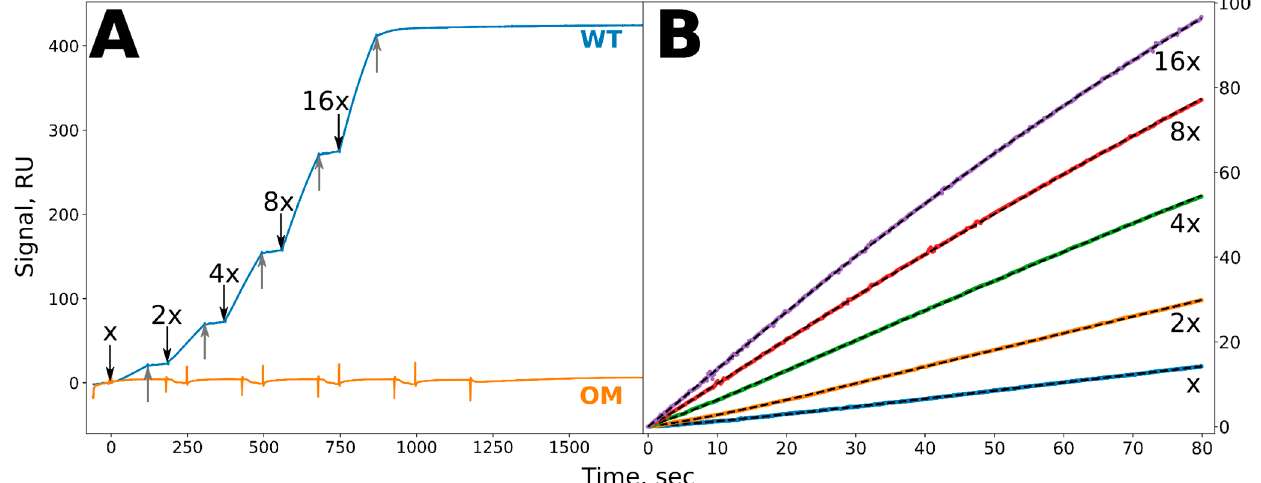
Figure 3. Binding kinetics between P4A1 antibody and WT or OM variants of RBD. ( A ) Binding kinetics for WT (blue) and OM (orange) RBD variants. In WT, the start of the binding phase is marked with black arrows, and the start of the dissociation phase is marked with gray arrows. Each sequential binding phase is conducted with a higher concentration of P4A1 (concentration is indi- cated above the corresponding arrow, x stands for 5 nm). For the OM variant, the same five-stage kinetics measurement was performed, and the start of each phase is obvious. ( B ) The binding phases are normed by the signal at the beginning. Colored curves correspond to the experimental signal, and dashed black lines represent the result of fitting with the Conformational Transition